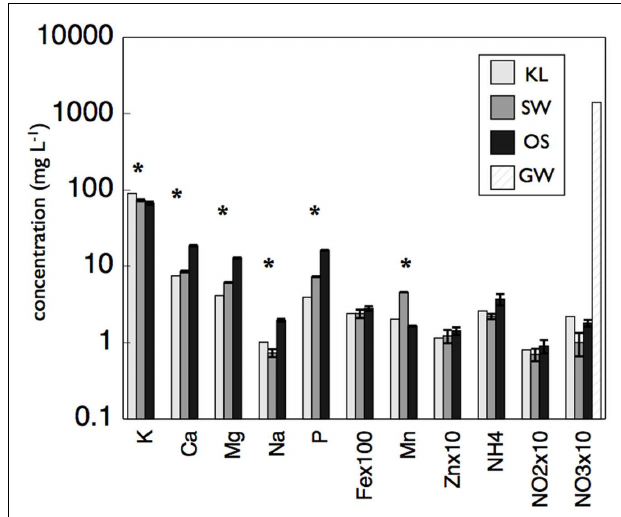
FIGURE 1 | Concentration of metals, NH 4 , NO x , and phosphorus (P) in concentrated beech leaf extract at a dissolved organic carbon concentration of 500mgL − 1 . We report average concentration from concentrate made on three separate dates. Error bars represent ± 1 SD. An asterisk indicates a significant difference ( p < 0.05) between all three ( Figure 5 ). SW had higher C:N but lower C:P and N:P leachates as determined byTukey HSD post hoc analysis.The leachate treatments were not significantly different in NO − but the GW was 3 significantly higher than all leachate treatments.